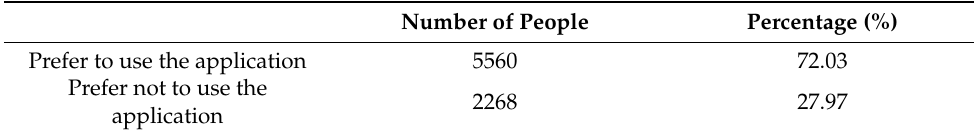
Table 5. Number of times the app is